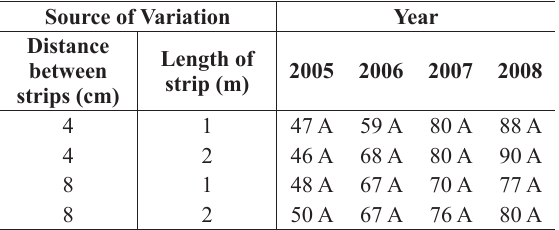
Percentage of bark recovery in Drimys brasiliensis , from experiment